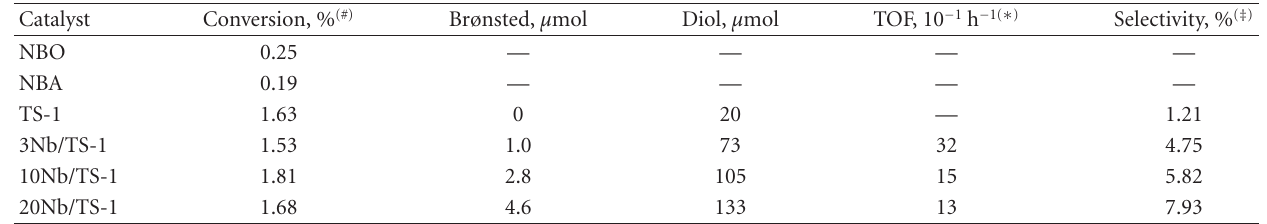
Table 4: Catalytic activity of the X Nb/TS-1 in the epoxidation of 1-octene with H 2 O 2 at 70 ◦ C for 48h.